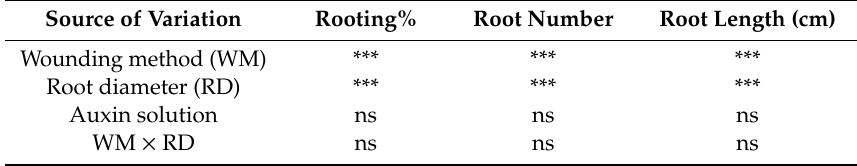
Table 5. ANOVA results of the main effects of wounding method (WM), root diameter (RD), and auxin solutions, and their interaction effect on the rooting, root length, and root number of Ficus elastica Roxb. Source of Variation Rooting% Root Number Root Length (cm) Wounding method (WM)